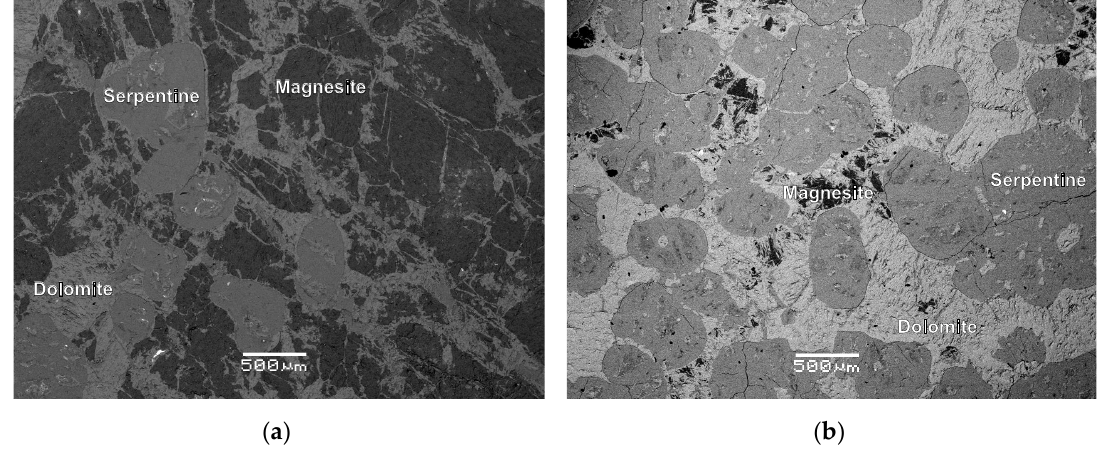
Figure 4. Backscattered electron images: ( a ) Magnesite ore; ( b ) dolomitic marble. Six samples were analyzed by XRD to confirm mineral identifications. Magnesite and dolomite were detected in the ore samples, as was a 7.3 Å phyllosilicate that texturally is likely to be antigorite serpentine. Cm-scale, post-tectonic fibrous veins were also confirmed to be brucite. A distinctive mica-rich sample was collected from the mine dump, and is similar to rocks described by [17] as typically found near the contacts with intrusive quartz monzonite. The XRD of this sample identified phlogopite and serpentine mixed with small amounts of illite, likely a mica weathering product. This sample also contains calcite and a 15.7 Å phase seen in glycolated XRD mounts that may be the mixed layer phyllosilicate